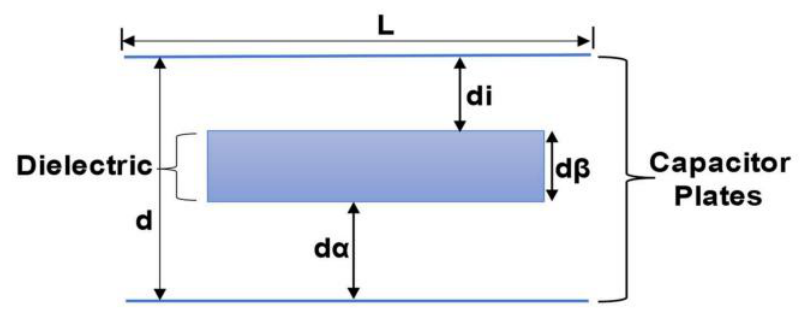
Figure 11. A Dielectric foreign object in a single module capacitive based CPT system. In the absence of a foreign object, i.e., ( ε r = 1) the capacitance is constant. For a foreign object or dielectric ( ε r > 1), the capacitance rising with ε r . By using the ANSYS Maxwell software, primary, secondary and coupling capacitance values can be simulated at various thicknesses of the related dielectric medium based on the constant parameters. These parameters comprise air gap distance ( d ), plate dimension and distance from the transmitter plate ( di ). The C m 1 . values are taken for five distinct materials namely aluminum (al), polyethylene (poly), PVC, glass and high-density polyethylene (hdpe). Generally, the respective relative permittivity as 4–10, 1–3.4, 2.7, 2.25 and 8.2, respectively. The plot of C m 1 v/s thickness of the foreign material for these five different materials has been plotted in Figure 12.